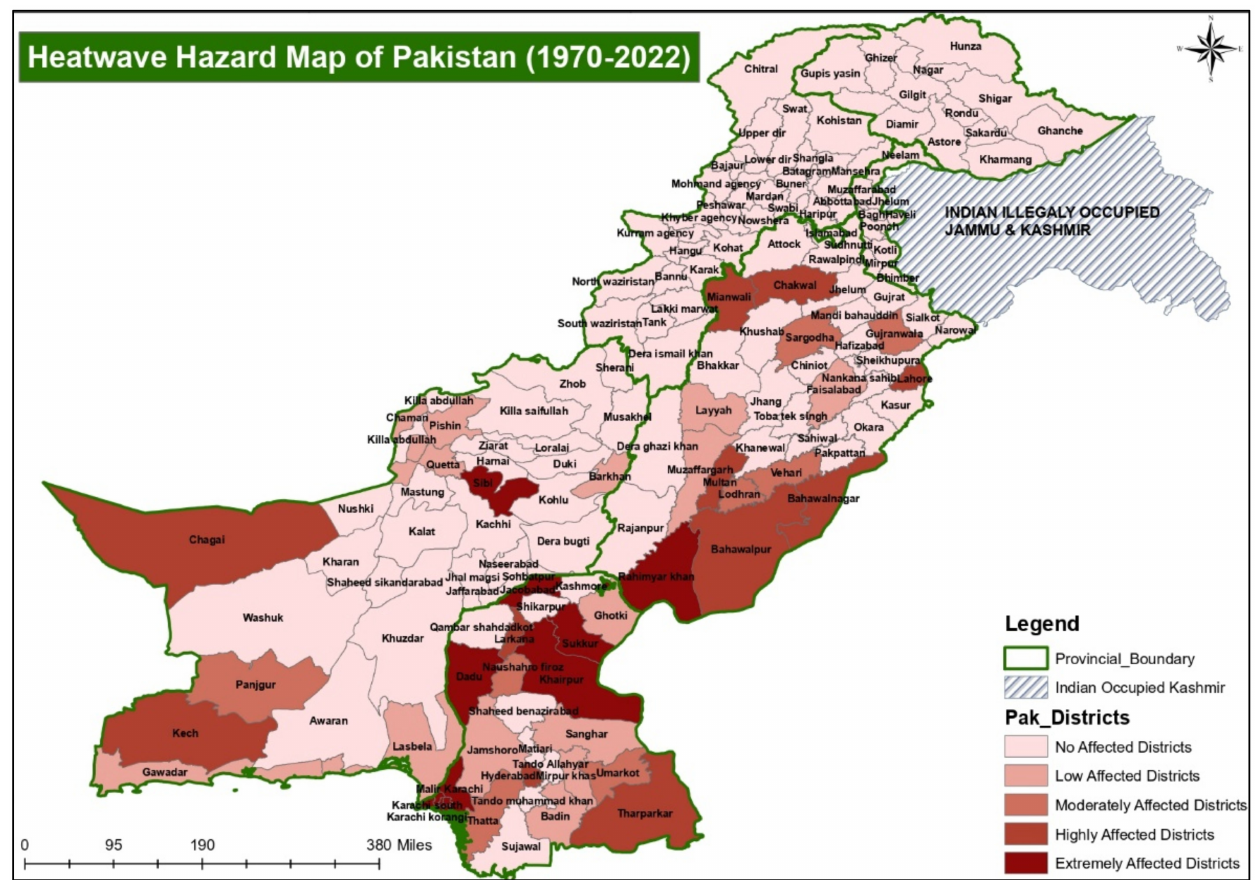
Figure 11. Pakistan Landslide Hazard Map 1970–2020 showing the intensity of heatwaves at district